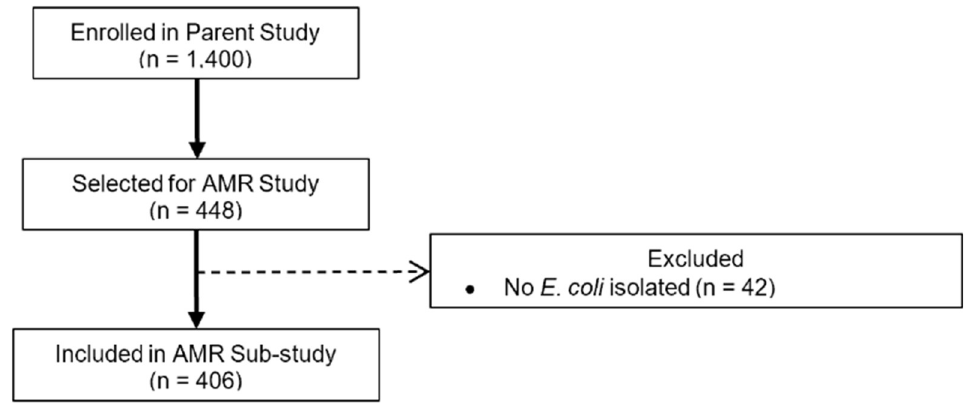
Fig 1. Participant flow